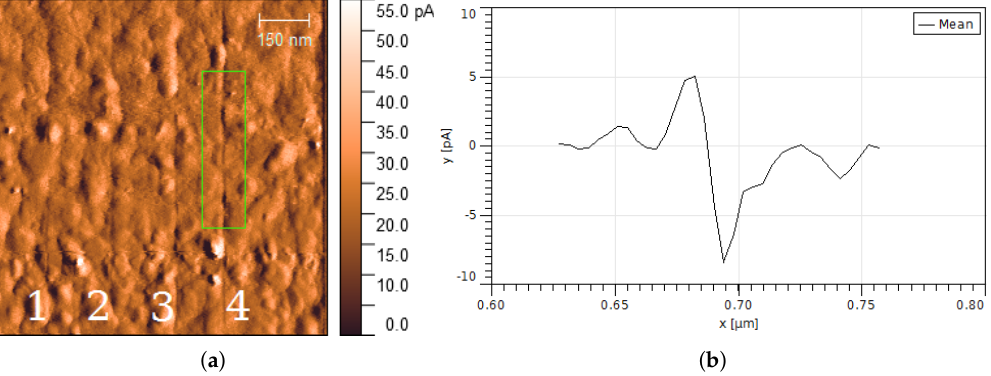
Figure 5. Nanolithography depending on laser intensity. Gold on mica (30 nm thickness) ( a ) after laser irradiation at four vertical lines (slow axis scanning from left to right stopped). I = 0.2, 0.3, 0.4, 1.0 × 10 8 W/cm 2 , angle of incidence θ = 88 ◦ , scanning speed 0.38 µ m/s; ( b ) averaged line profile